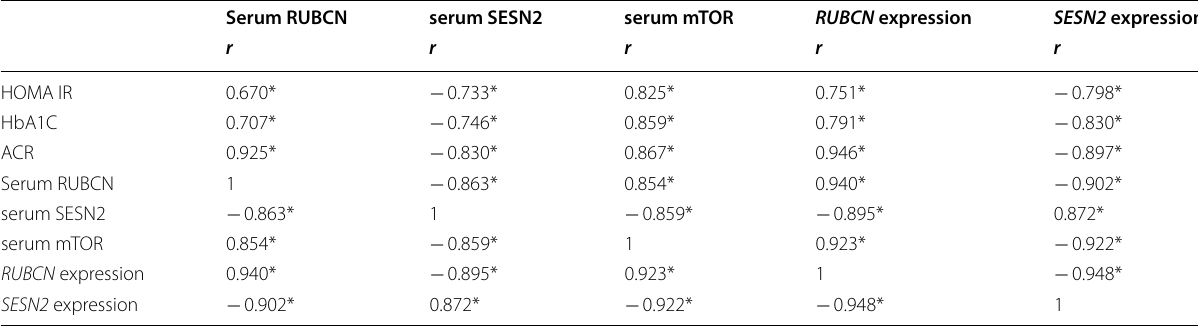
* indicates statistical significance ( P < 0.05); r Pearson correlation coefficient. All calculated P were significant < 0.001 = HOMA-IR: Homeostatic Model Assessment of Insulin Resistance; HbA1C; Glycated hemoglobin; ACR: Albumin/Creatinine ratio in urine; RUBCN: Rubicon; SESN2: Sestrin2; mTOR: mammalian target of Rapamycin Pearson’s correlation test was used